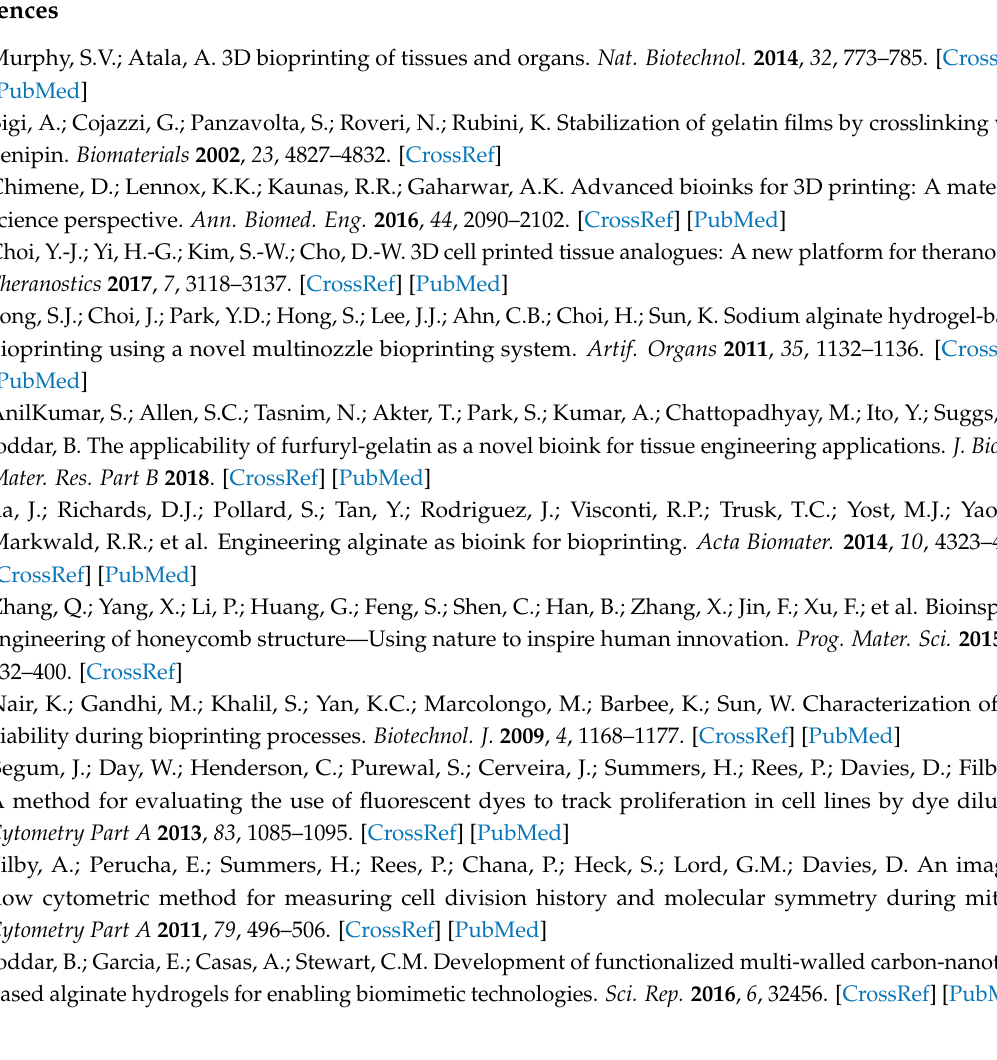
Figure S1: Low magnification images of lattice and rectangular-sheets, Figure S2: FACS analysis of controls, Figure S3: Fabrication of a lattice structure. Supplementary methods are also